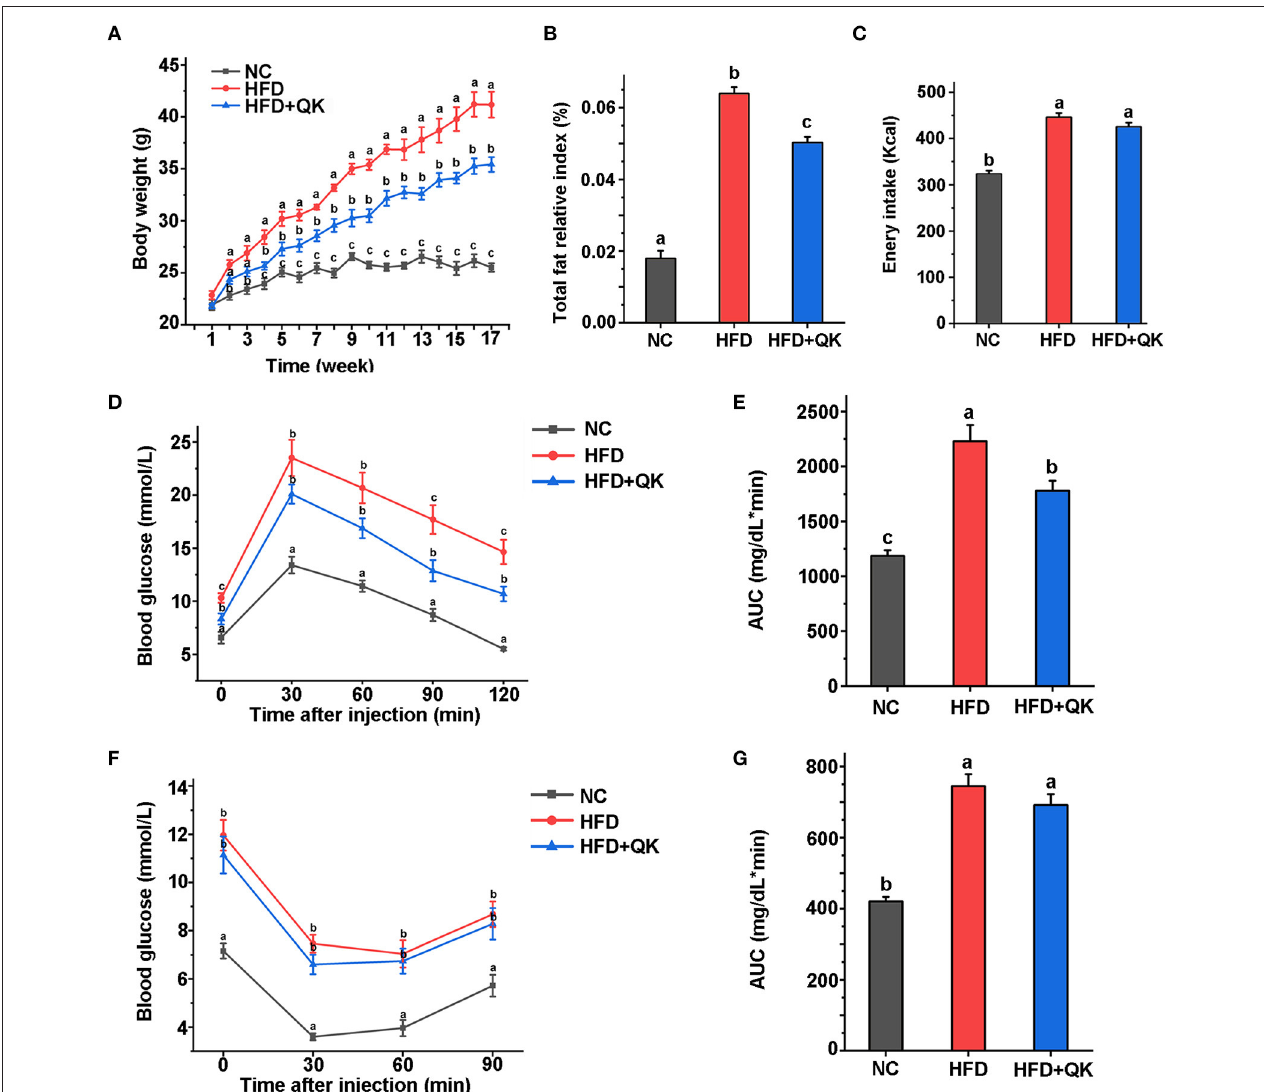
FIGURE 1 | Effects of the intake of WGQK on obesity and diabetes-related parameters. (A) Mean weekly body weight of the NC, HFD, and HFD + QK groups ( n = 5); (B) Mean total fat relative index (total fat weight/body weight) of each group after 16 weeks of the diet intervention; (C) Mean weekly energy intake of each group; (D) Blood glucose levels at different time points during glucose tolerance test (GTT); (E) Mean areas under the curve (AUC) of GTT; (F) Mean blood glucose levels during insulin tolerance test (ITT); (G) Mean area under the curve (AUC) of ITT. Data are presented as mean ± SD ( n = 5). Significant difference was determined using an unpaired two-tailed t -test, different superscript letters of any two means represent significant differences ( p <